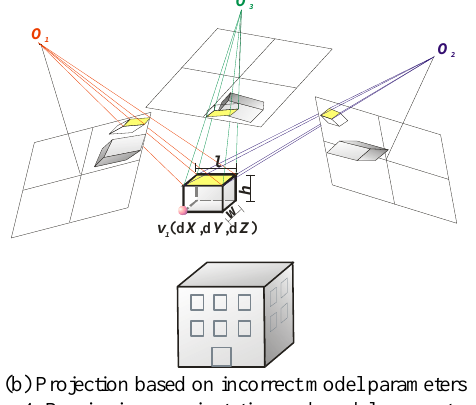
Figure 4: Precise image orientation and model parameters are both required for correct model projection